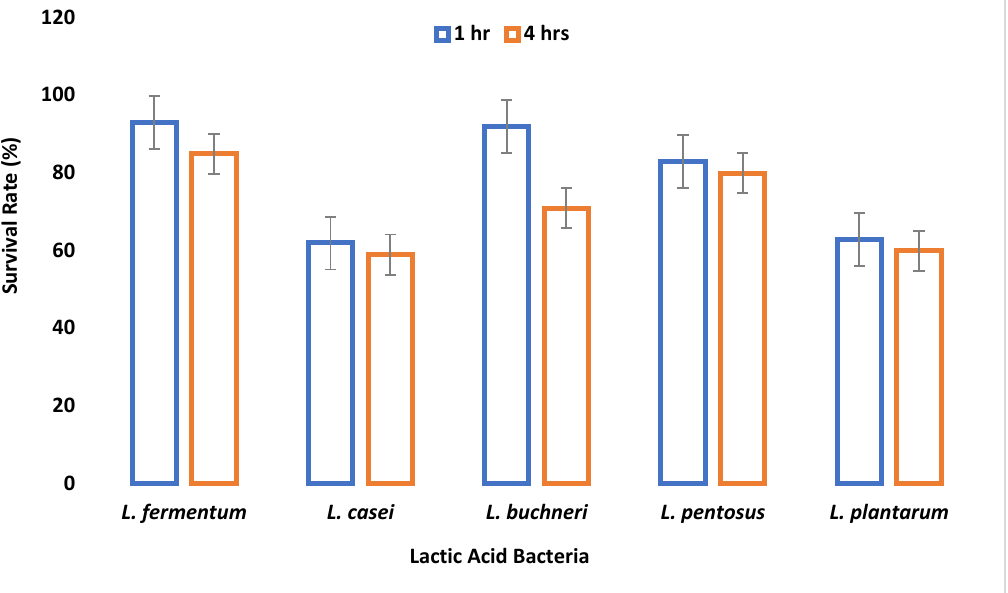
Figure 4. Survival of lactic acid bacteria isolates in 0.3% bile salt after 1 and 4 h, respectively. L. fermentum and L. buchneri survived well in 0.3% bile salt concentration after 1 h however after 4 h, the rate of survival of L. buchneri and L. fermentum decreased slightly.